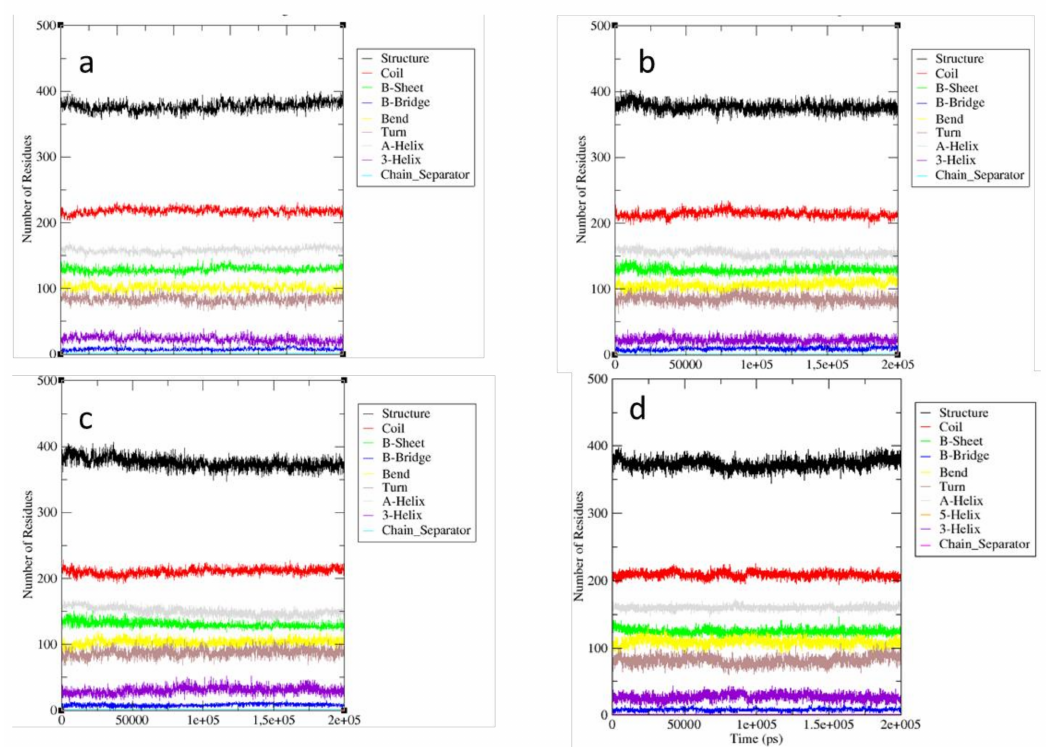
Figure 6. DSSP analysis for simulations with arginine in the central cavity. ( a ) wtGALT + arginine; ( b ) p.Gln188Arg + arginine; ( c ) wtGALT + G1P + H2U + arginine; ( d ) p.Gln188Arg + G1P + H2U + arginine.